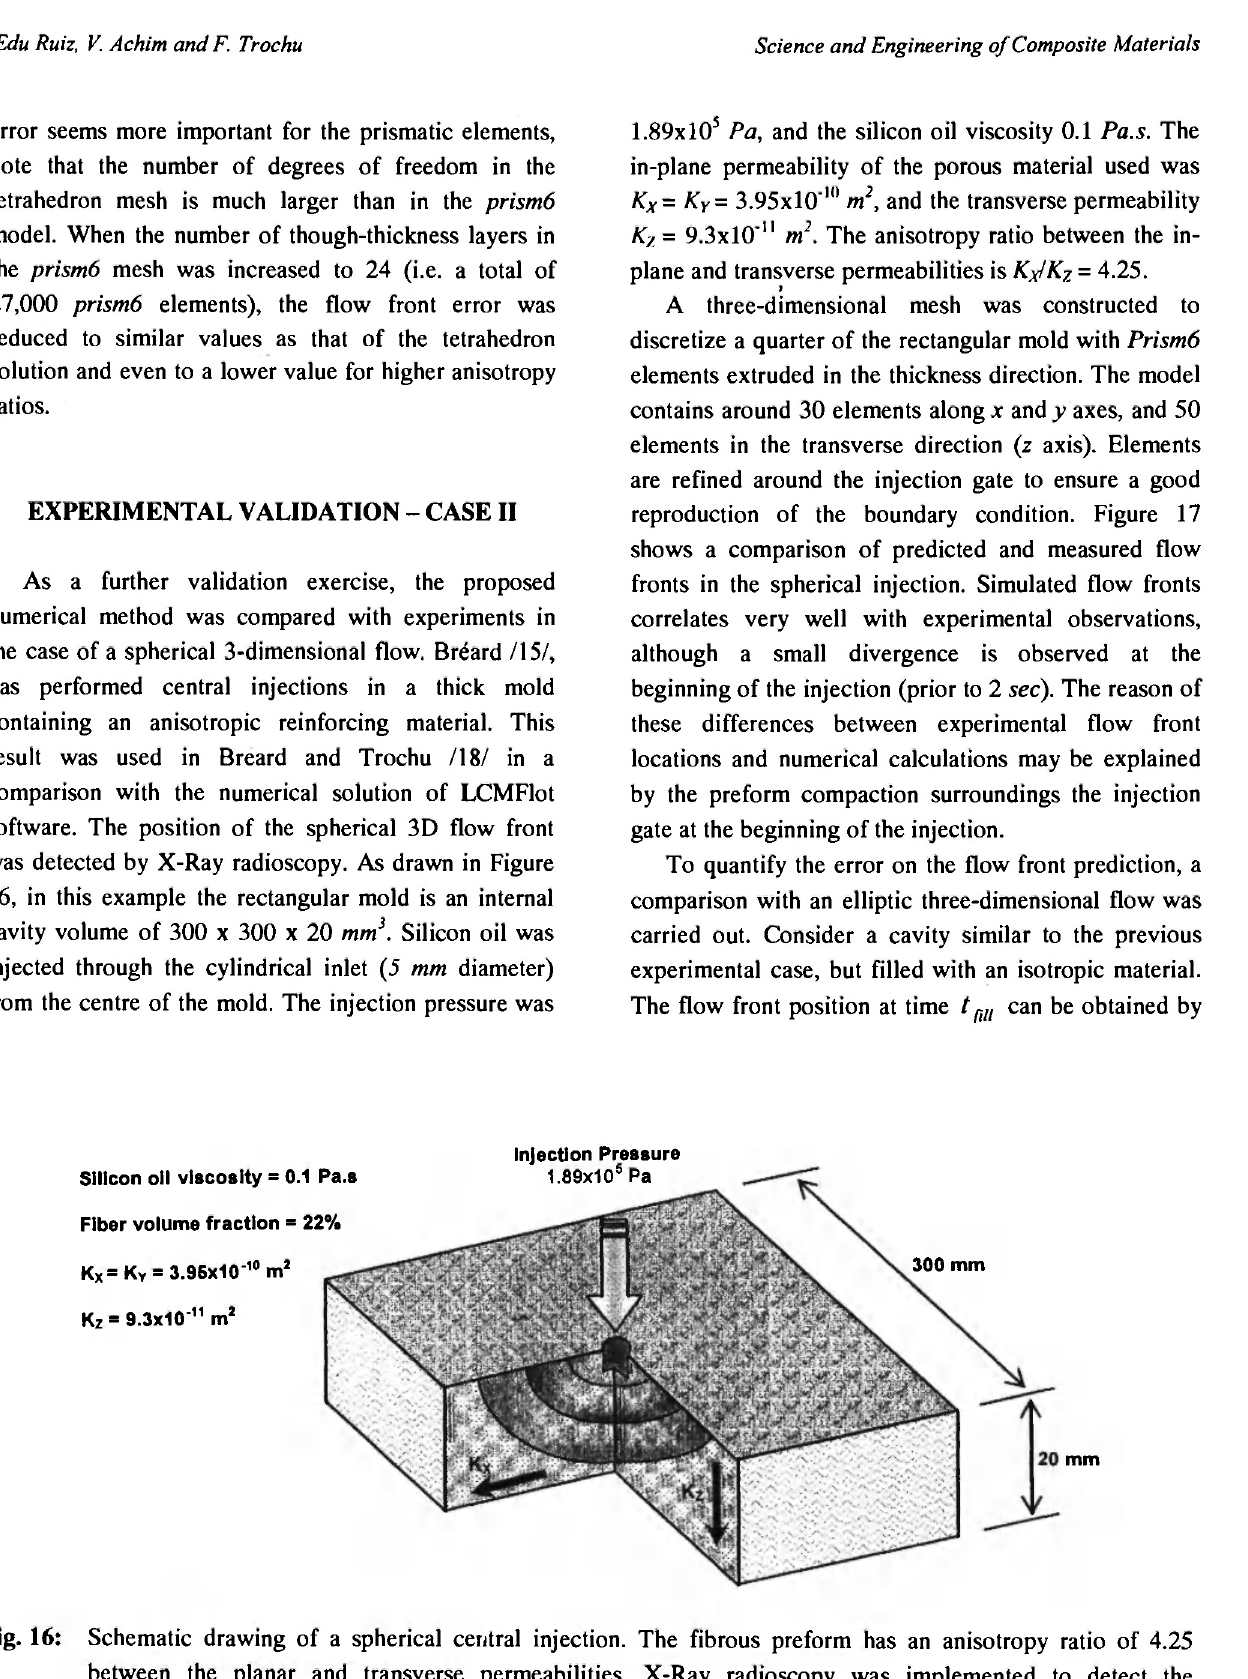
Fig. 16: Schematic drawing of a spherical central injection. The fibrous preform has an anisotropy ratio of 4.25 between the planar and transverse permeabilities. X-Ray radioscopy was implemented to detect the progression of the three-dimensional fluid flow (Bröard et al.